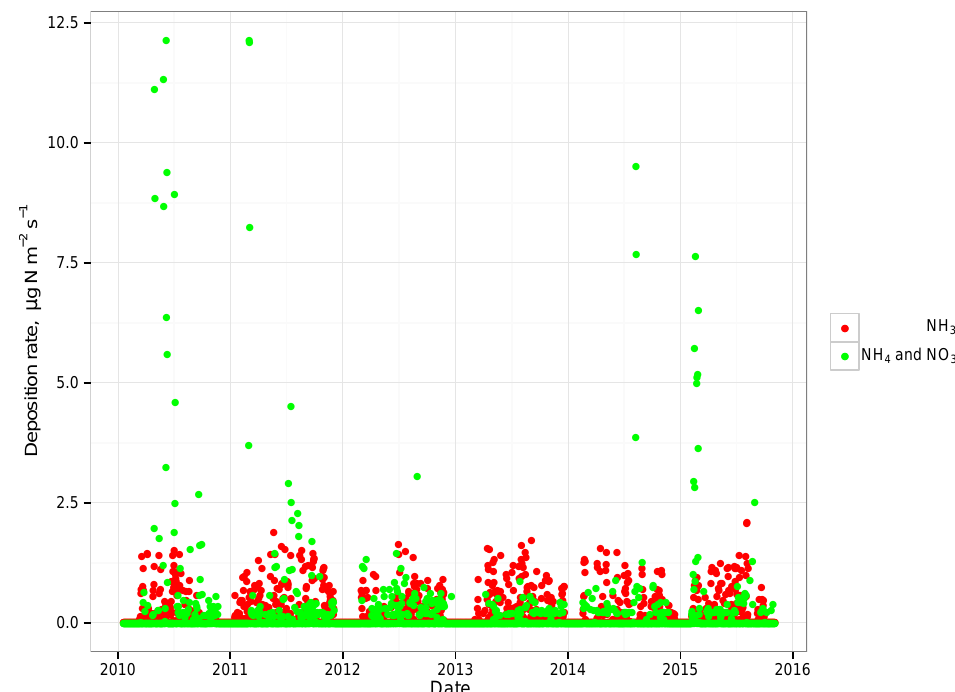
Figure 2. Daily mean nitrogen deposition rates in the NH + deposition was calculated from the duration of spraying events each day, multiplied by the NH + accounting for the area covered by the spray. NH 3 deposition was calculated from the duration of fumigation events each day, measurements of NH 3 concentration, and meteorological data, using the method of Cape et al.